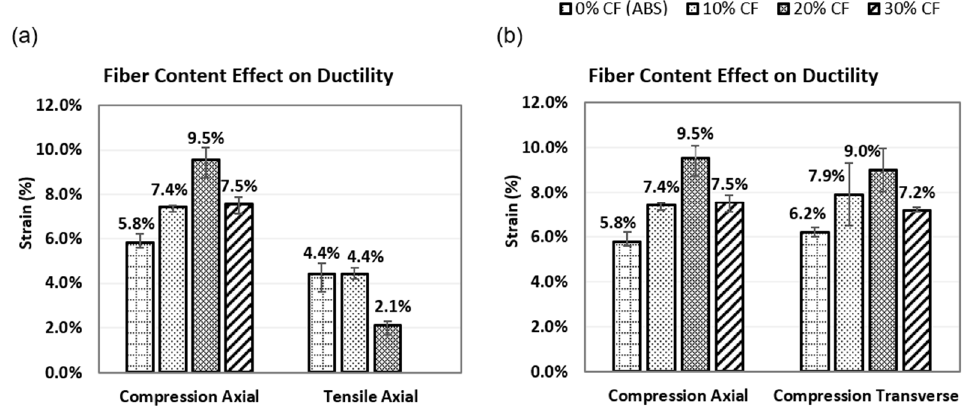
Figure 6 . Fiber Content Effect on the Compressive Ductility of AM Fabricated CFRP Composites ( a ) Axial versus Transverse Compression ( b ) Axial Compression versus Axial Tensile . ( a ) Axial versus Transverse Compression ( b ) Axial Compression versus Axial